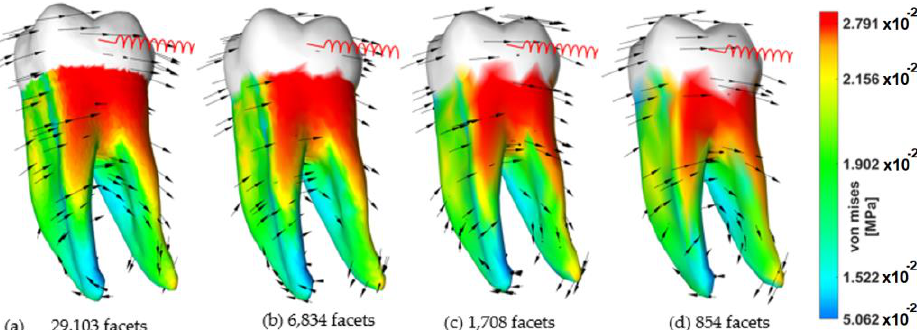
Figure 6. Comparison of stress on an upper right canine due to 2.94 N load after 0.5 mm anchorage movement. Black arrows plotted using [49]. The red spiral represents the external force.